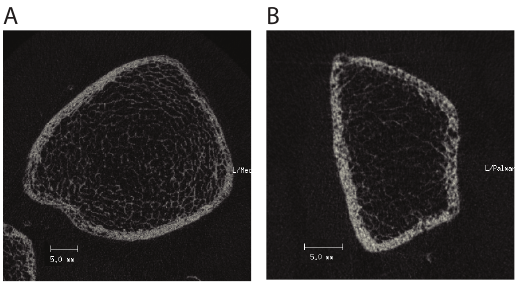
Fig 1. HR-pQCT sections of tibia and radius. Representative images of tibia (A) and radius (B) from hemodialysis patients with high cortical porosity. (A): tBV/TV (%): 14.6, Ct.Po (%): 11.54; (B): tBV/TV (%): 7.7, Ct.Po (%): 11.49.